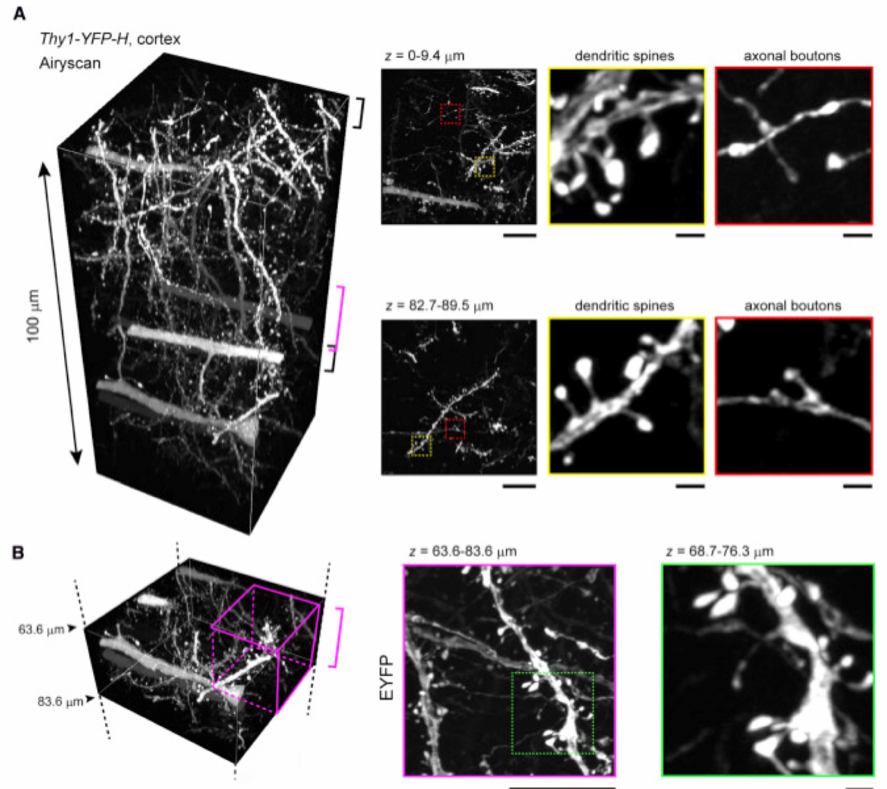
Figure 3. SeeDB2 allows for deep-tissue imaging with SRM resolution. ( A ) Tissue blocks of the cerebral cortex from an adult Thy1-YFP-H mouse were cleared with SeeDB2S; ( B ) upon Airyscan imaging, dendritic spines were identifiable ~100 µ m deep into the sample. Reproduced